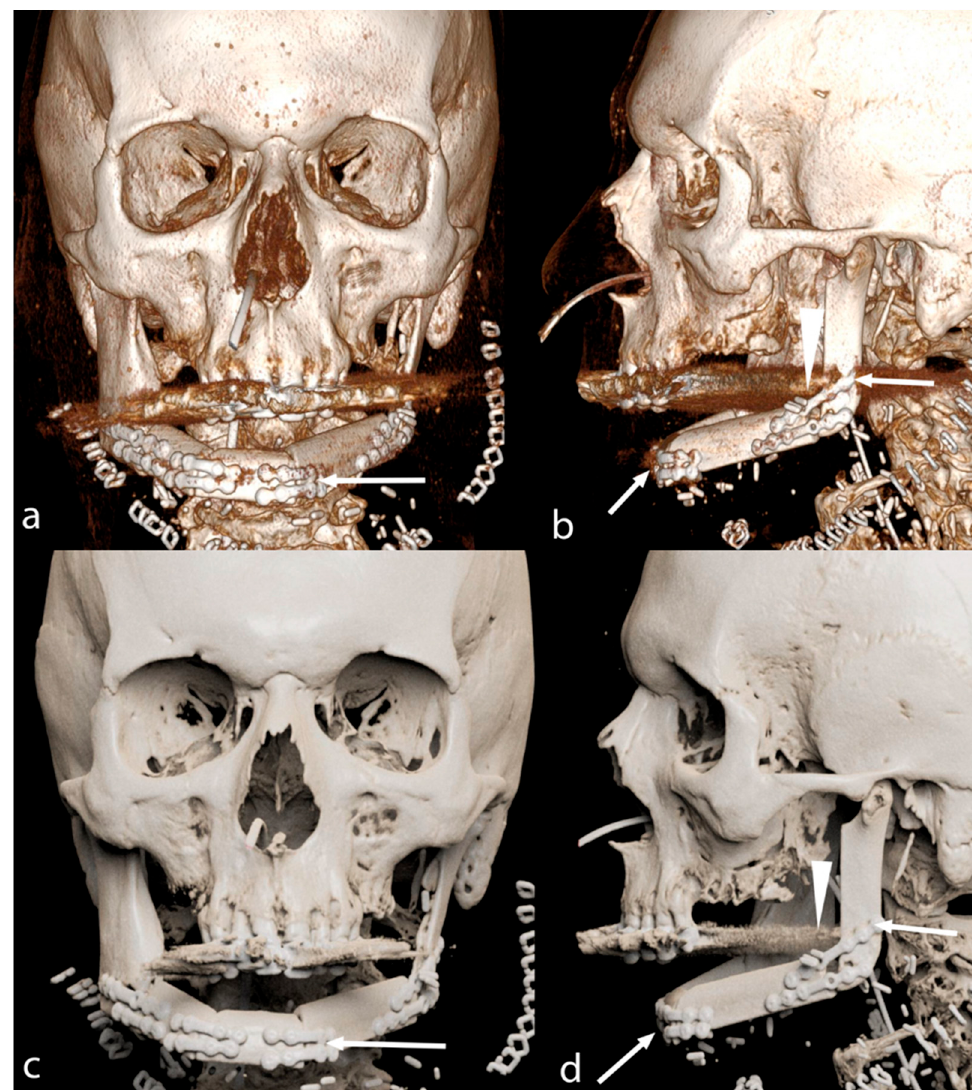
Figure 4. VR ( a , b ) and PT ( c , d ) reconstruction of fibular bone flap. In PT images, there are fewer metal artefacts from non-removable dental implants (arrowheads) and metal bone flap fixation materials (arrows). Table 3. Likert’s scale evaluation results across all readers and parameters. Values are expressed as median (MDO, RN, VF, GM, NC = readers; VR = volume rendering; PT = path